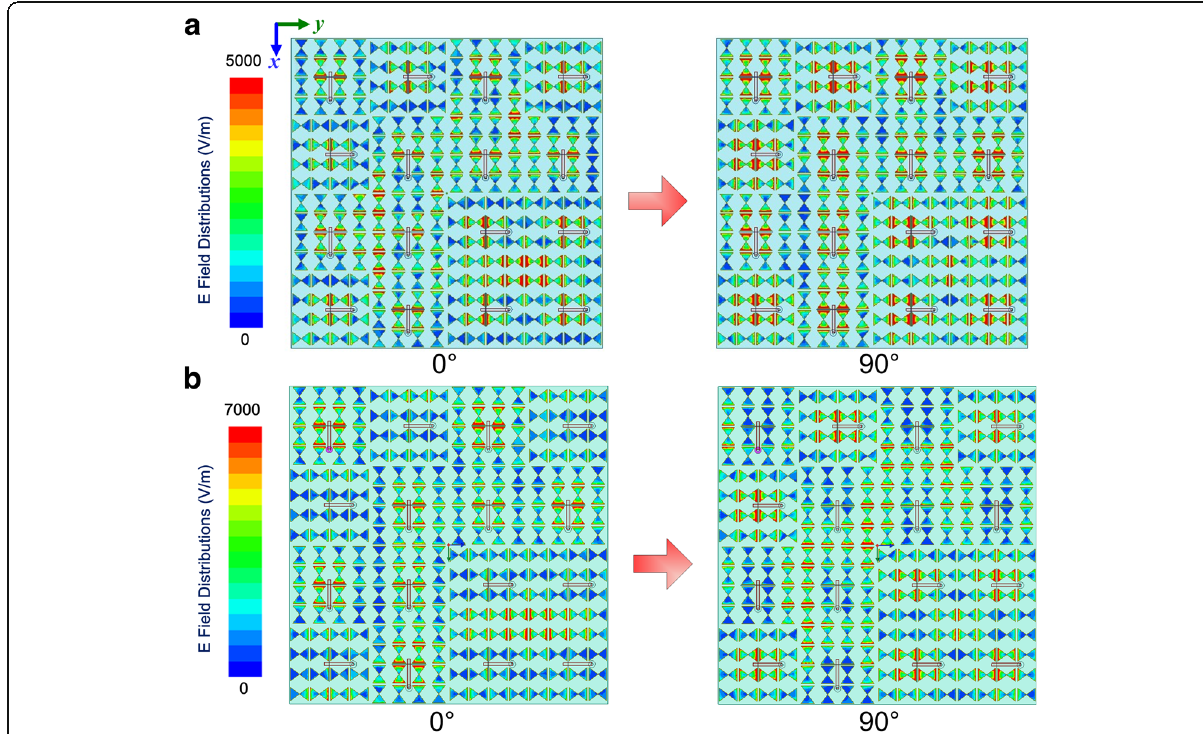
Fig. 8 Electric field distributions of the EMMS at 5.35 GHz with different time variants. a LP radiation case. b RHCP radiation